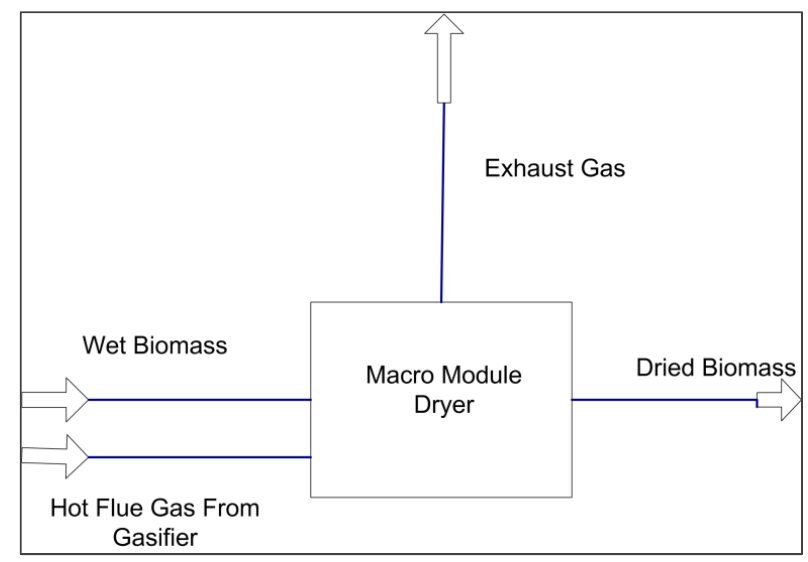
Figure 2. An overview of the rotary dryer